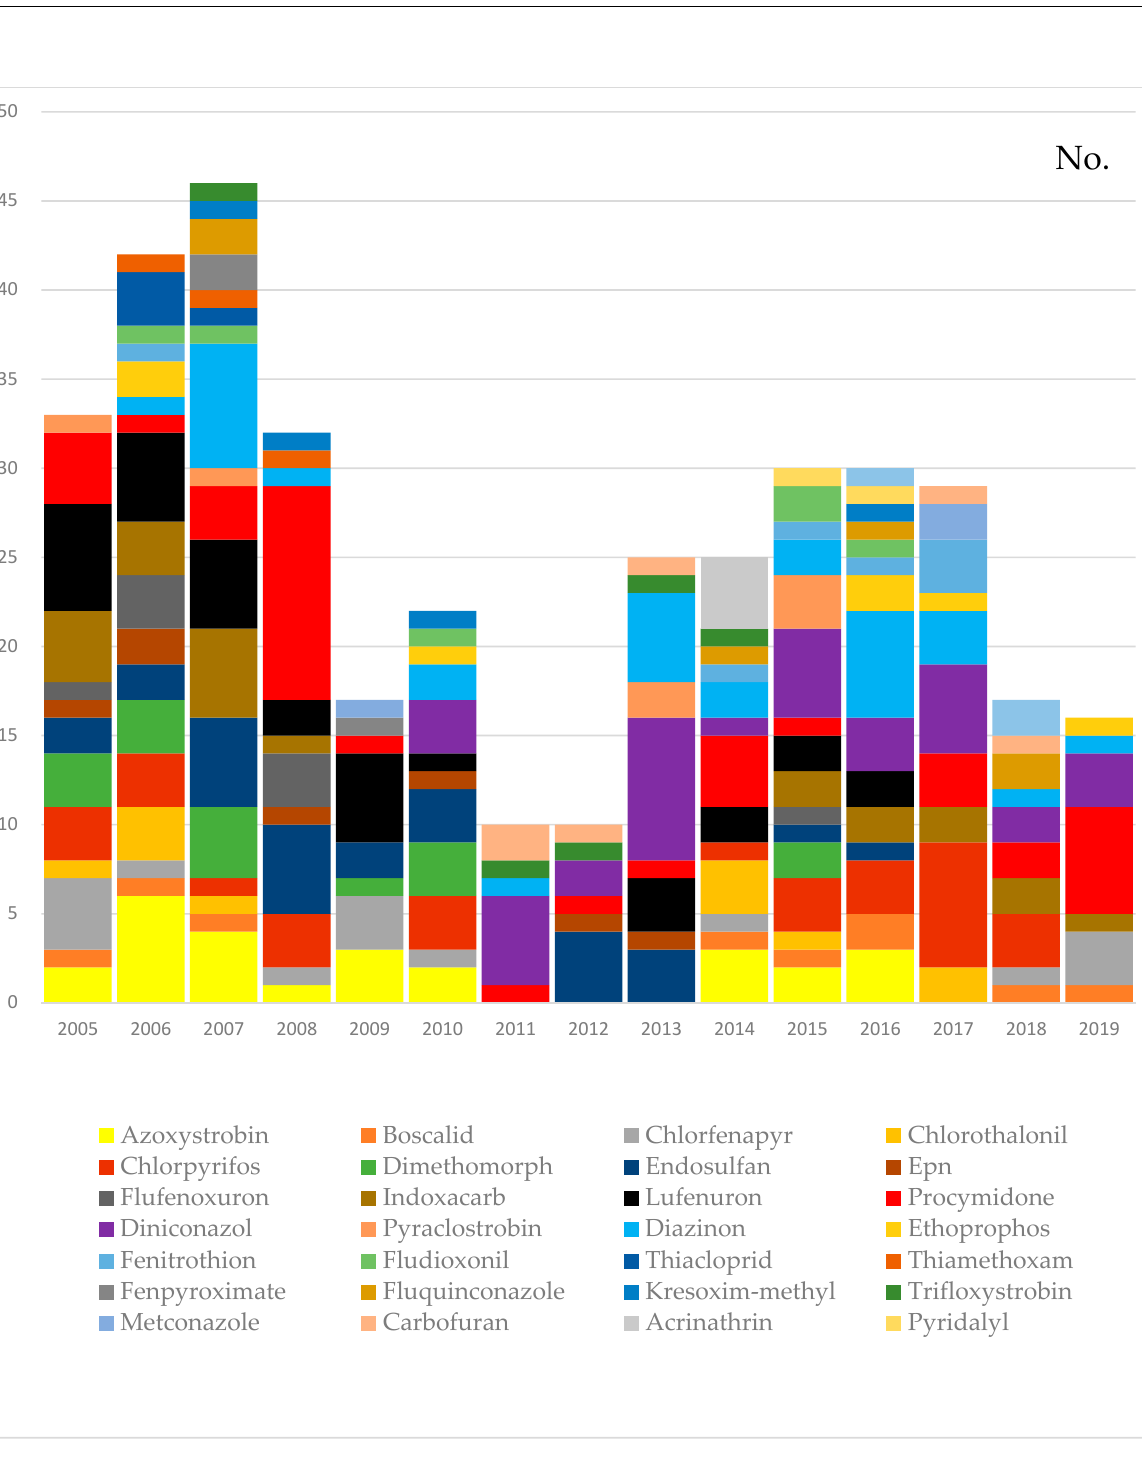
Figure 3. Annual distribution of pesticide residues exceeding the maximum residue limits ( MRLs) in samples analyzed from 2005 to 2019.